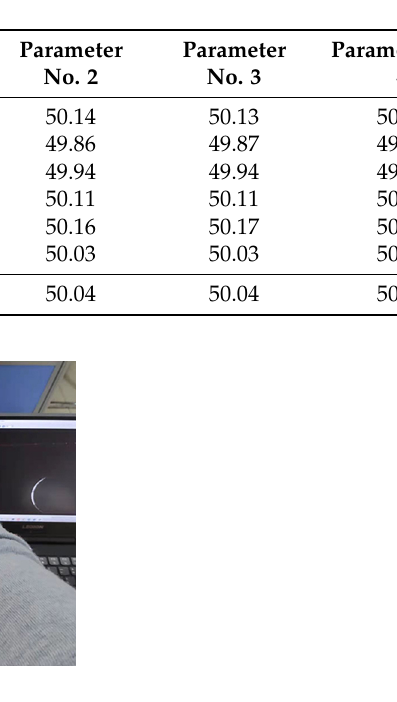
Table 2. The measurement results of LTS sensor.